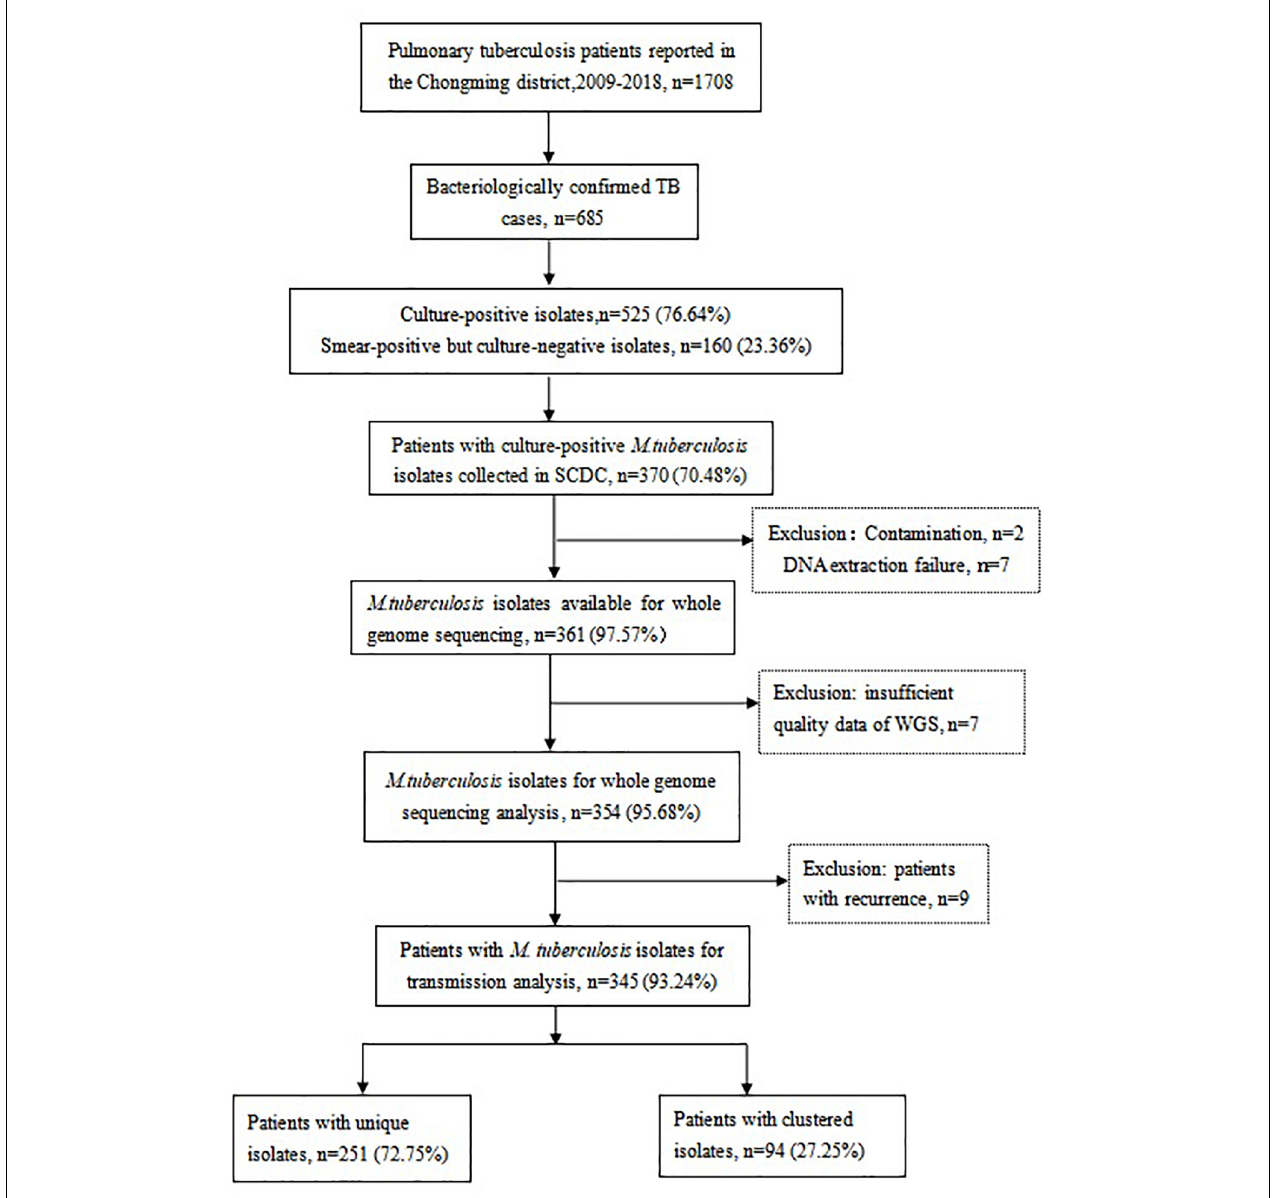
FIGURE 1 | Flow chart of study population and selection.